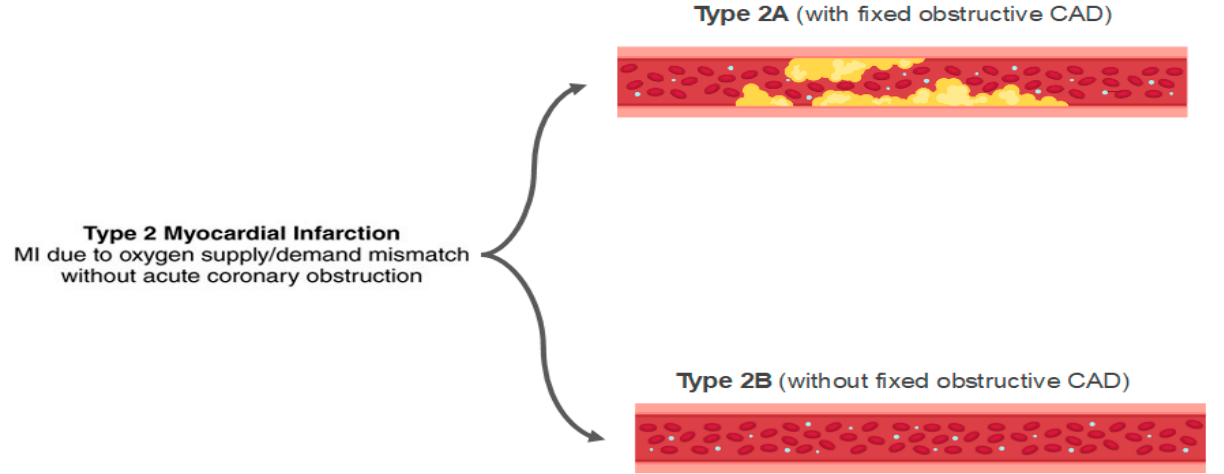
Figure 8. Classification of type 2 acute myocardial infarction (AMI). MI: myocardial infarction; CAD: coronary artery disease.